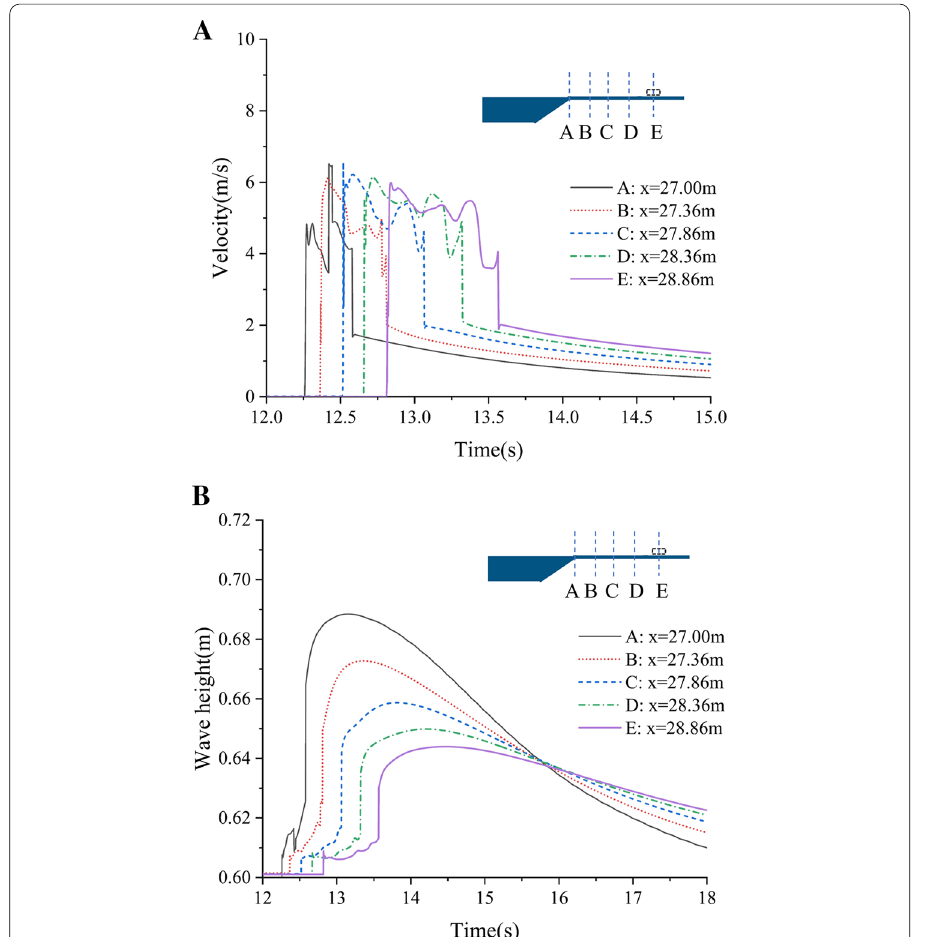
Fig. 11 Flow velocity time histories ( a ) and bore height time histories ( b ) at different monitoring